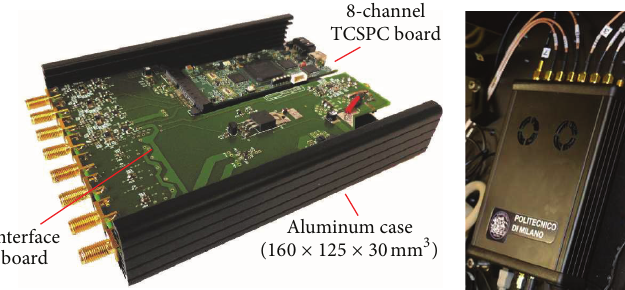
Figure 13: Photographs of the 8-channel PoliMi TCSPC